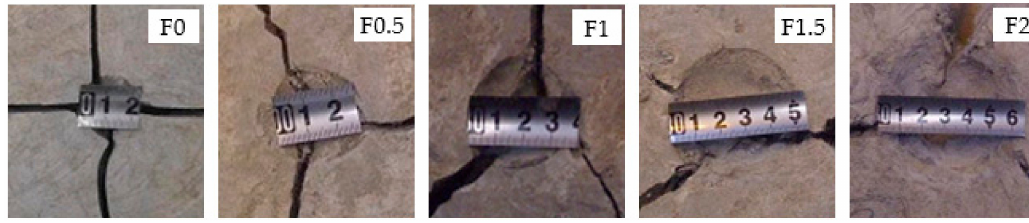
Figure 4. Impact craters of PVA-FRCM disc